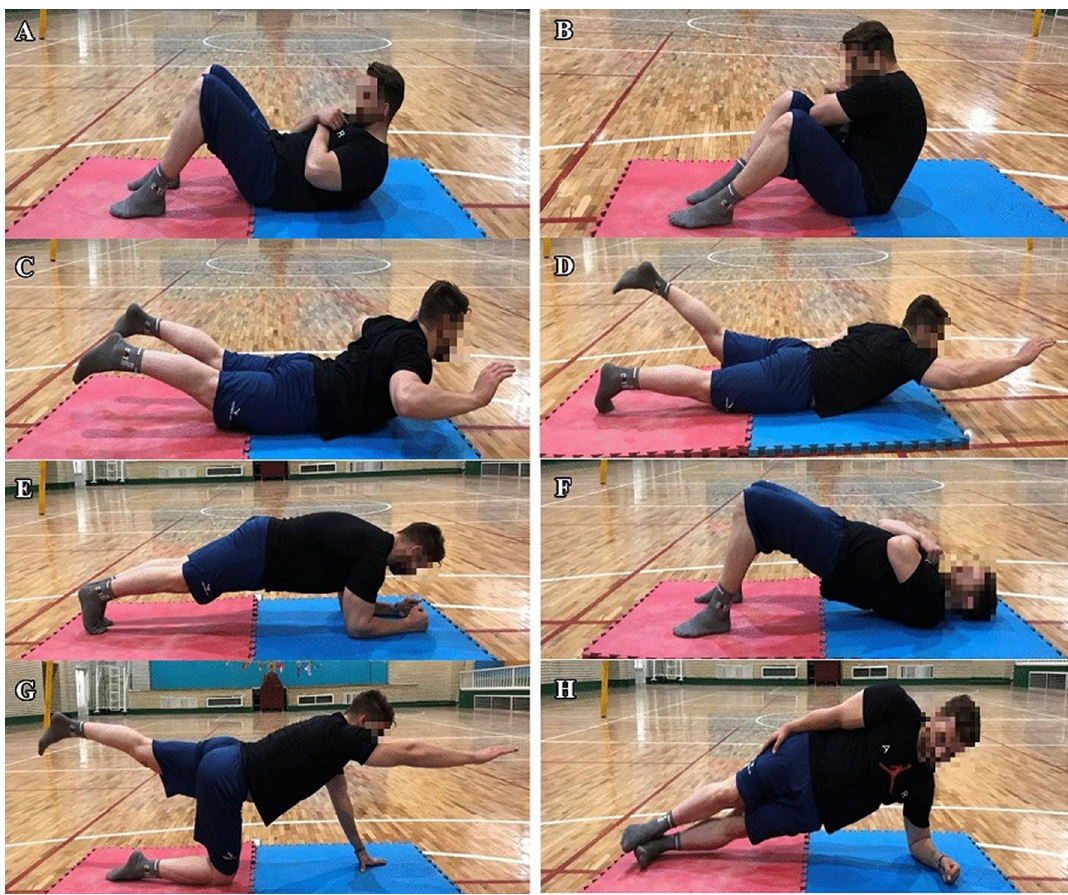
Figure 2. Core stability training program; Sit-up-1 ( A ), Sit-up-2 ( B ), Back extention-1 ( C ), Back extention-2 ( D ), Front plank ( E ), Back bridge ( F ), Quadruped ( G ), Side bridge ( H